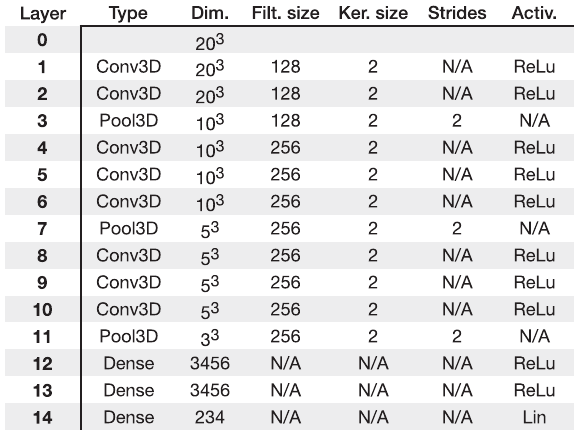
FIG. 12. Sketch of the NN layout for the 3D nonsymmorphic case